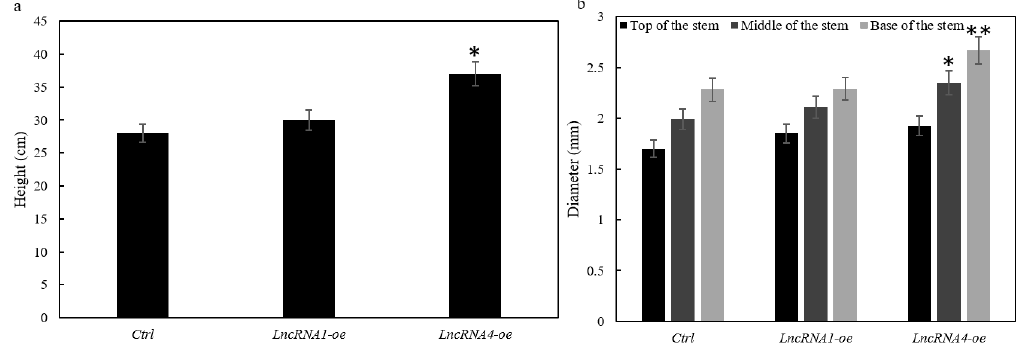
Figure 7. Plant height and root of overexpression and wild type 84K poplar trees. Bars represented standard errors (SE), * represented the significant difference ( p < 0.05), and ** represented the highly significant difference ( p < 0.01). Values were reported as means ±SE ( n = 4).